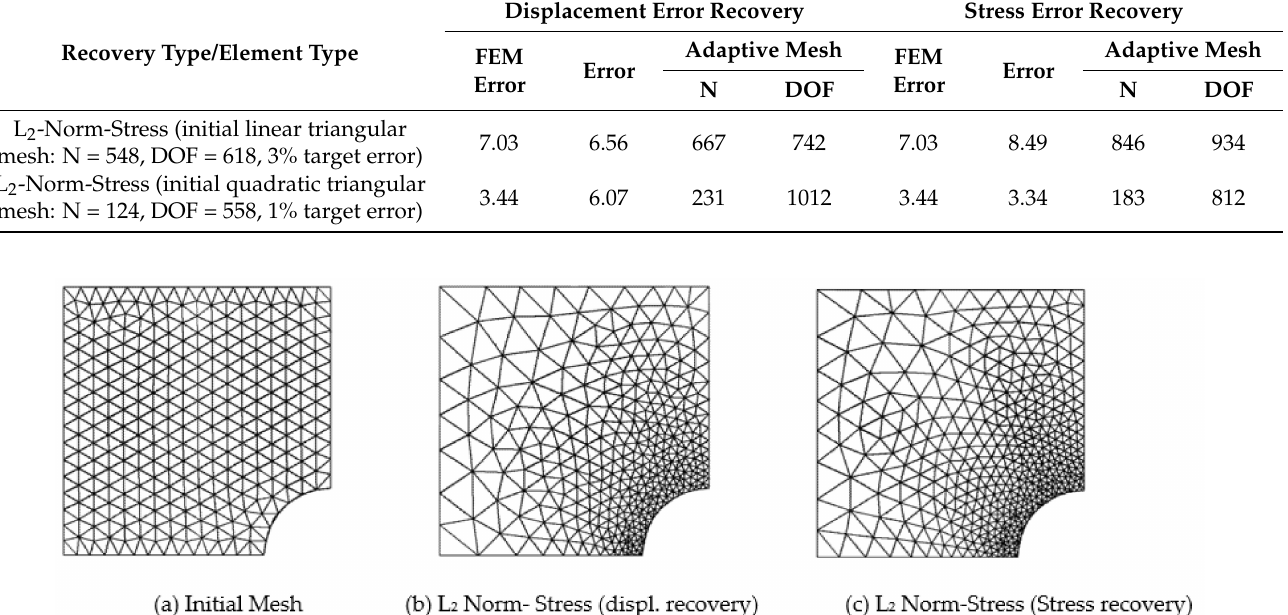
Figure 7. Adaptive mesh required for 3% target error (L 2 -Norm) in compressible elastic square plate with circular inclusion example solution variables considering displacement and stress recovery techniques (Initial regular linear triangular mesh: N = 548, DOF = 618).